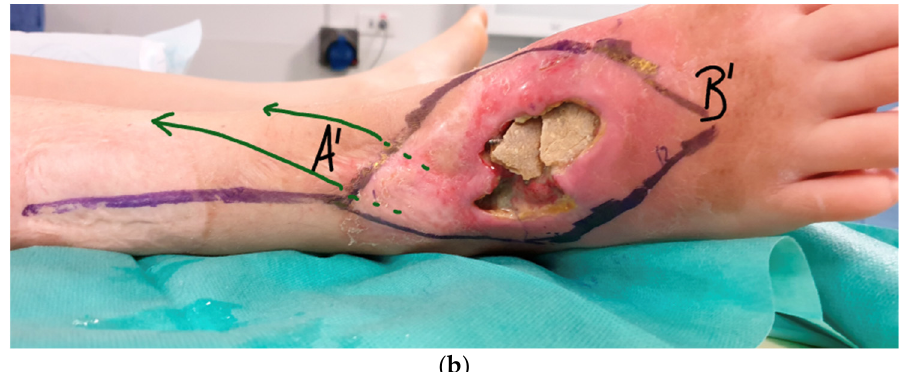
Figure 3. ( a ) An example of ALT flap pre-operative planning. ( b ) Cutaneous radionecrosis. ALT flap-based reconstruction was planned. Green arrows show the direction of lymphatic pathways. The A extremity of the ALT will be inserted in the A’ extremity of the defect and the B extremity of the ALT flap will be inserted in the B’ extremity of the defect to respect the lymphatic direction.